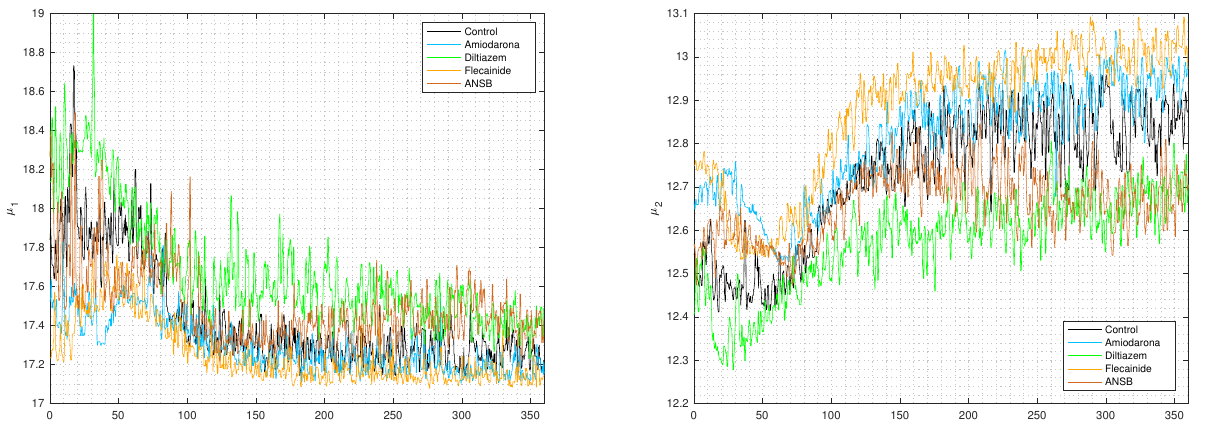
Figure 3. Audio features were obtained for VF recordings in different conditions. The time evolution for each time window is represented by the example of the spectral centroid ( left ) and the spectral spread ( right ) on an example recording of each condition. Despite the variance and fluctuations over time, trends can be observed in different time periods for different